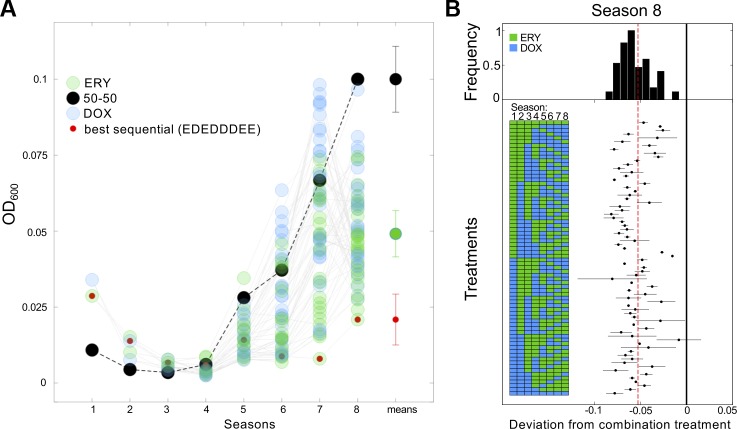
At IC50 dosages, population recovery is fastest for the 50/50 combination treatment and slowest for a sequential treatment.(A) Mean densities are shown at the end of each season for all sequential treatments at IC50 (as blue and green dots) and for the 50/50 combination of both drugs (black dotted line). The treatment maximising inhibition in season 1 (at 12 h) is the 50/50 combination treatment, because of the synergy. However, by season 8 (at 96 h), all sequential treatments produce lower mean densities than the 50/50 treatment, out of which the lowest density obtained from all the treatments tested is indicated by red circles. Also shown are mean final densities (see x-label “means”) of the 50/50 treatment (black circle), the best sequential treatment (red circle), and of all sequential treatments (green circle ± SE, three replicates per treatment). (B) A forest plot showing densities obtained using different sequential treatments at 96 h relative to the 50/50 treatment (drug orders are illustrated by the blue and green boxes on the left). The vertical black line represents the mean density for the 50/50 combination, the vertical dashed line is the mean of all the sequential treatments, and the dots mark the deviation in density produced from the 50/50 combination treatment (± SE, n = 3). Like (A), this shows that the combination treatment performs at the poorest extreme of the distribution of all sequential treatments measured in terms of how bacterial growth is suppressed by 96 h. There is no evidence of bacterial clearance in any treatment. (S1 Data contains the data used in this figure.)